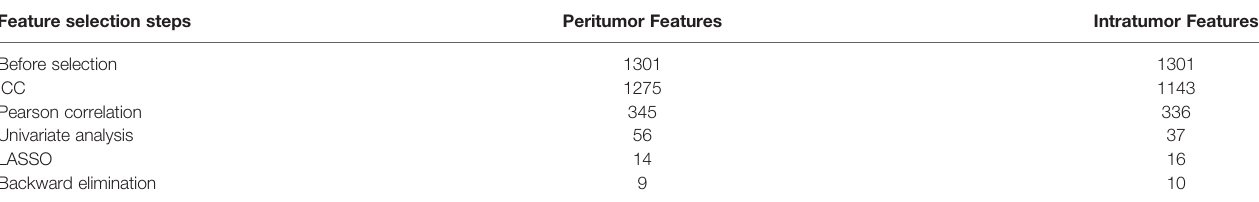
TABLE 4 | Numbers of features that remained after each selection step for radiomics signature construction.